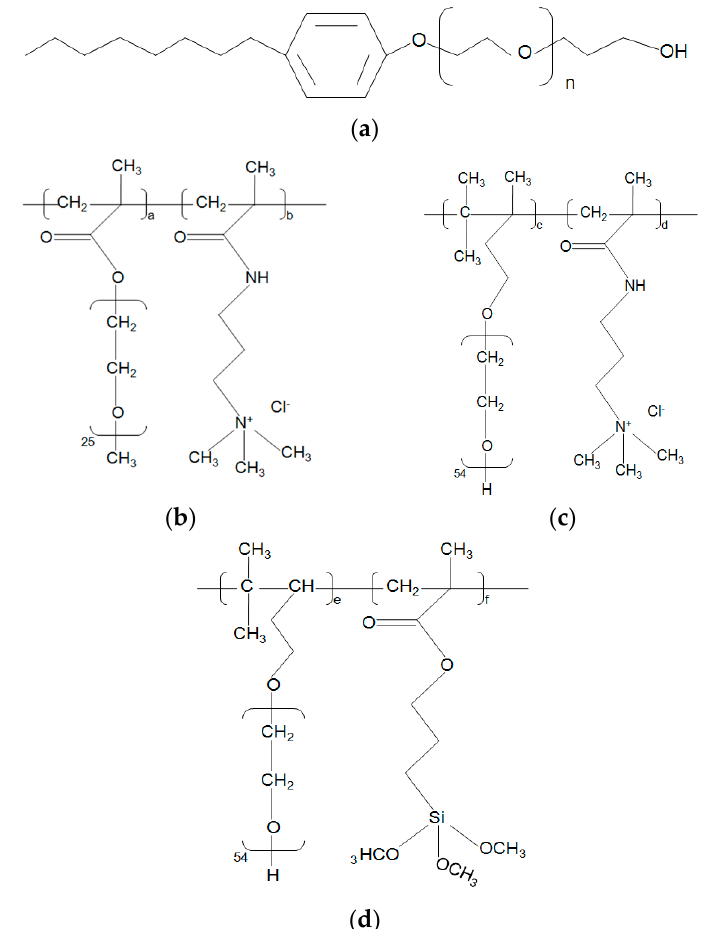
Figure 1. Chemical molecular structure of four surfactants. ( a ) Alkylphenol polyoxyethylene ether (APEO); ( b ) I-Cationic polycarboxylate (I-C-PCE) and ( c ) II-Cationic polycarboxylate (II-C-PCE); ( d ) Silane modified polycarboxylate (Silane-PCE).